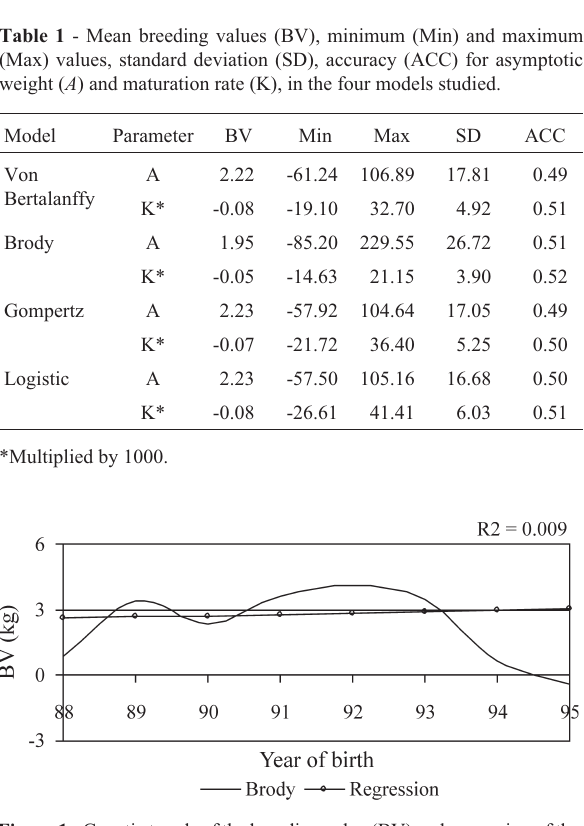
Figure 1 - Genetic trends of the breeding value (BV) and regression of the asymptotic weight by birth date of cows for the Brody